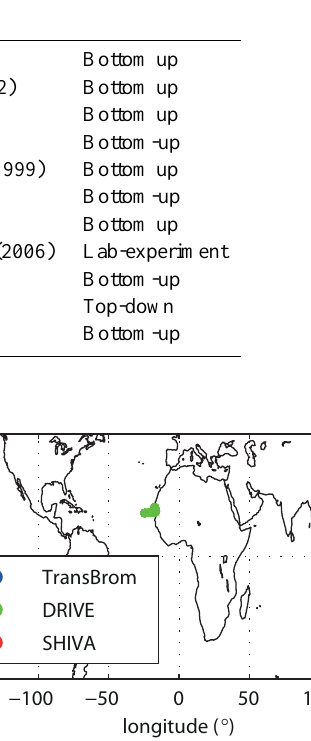
Fig. 1. Map of ship campaigns used in this